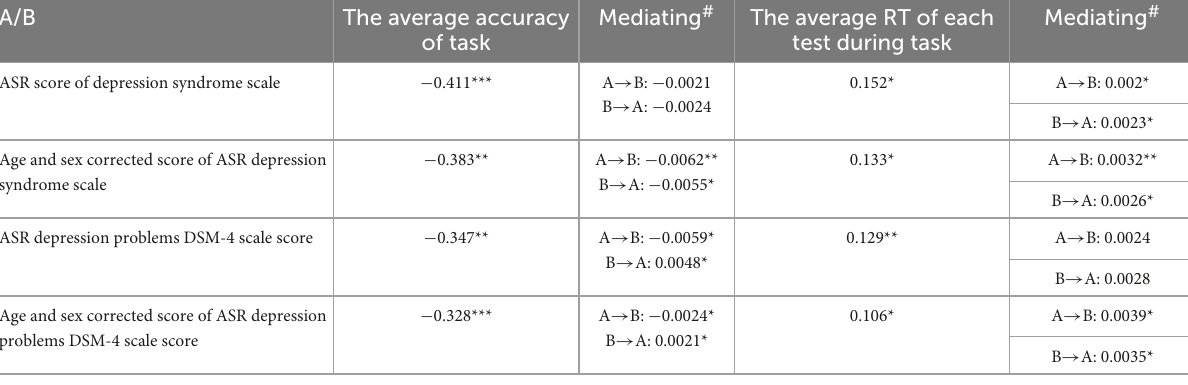
Mediating # The average RT of each Mediating # of task test during task